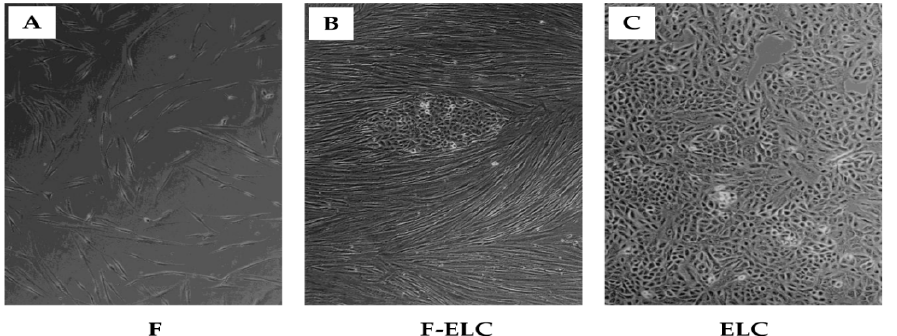
Figure 1. Human lung fibroblasts spontaneously convert into epithelial-like cells (ELC). Serial images of human lung fibroblasts (passage >10) cultured on coverslips in standard culture tech- nique. Some cells exhibiting an epithelial-like phenotype were observed, and up to 100% of cells showed the epithelial-like morphology could be detected. Cells grown on coverslips were fixed with acetone–methanol (2:1) and observed with phase-contrast microscopy (original magnification ×10). Fibroblasts showed the characteristic phenotype of fibroblasts and/or ELC. Original fibroblasts showing a fusiform and dispersed configuration ( A ). An area with typical fibroblasts and ~20% of ELC exhibiting the polygonal/cobblestone shaped, closely connected, and focally accumulated appearance ( B ). An area covered at 100 % of ELC, where fibroblasts are not apparent ( C ). F: fibroblast; ELC: epithelial-like cell.